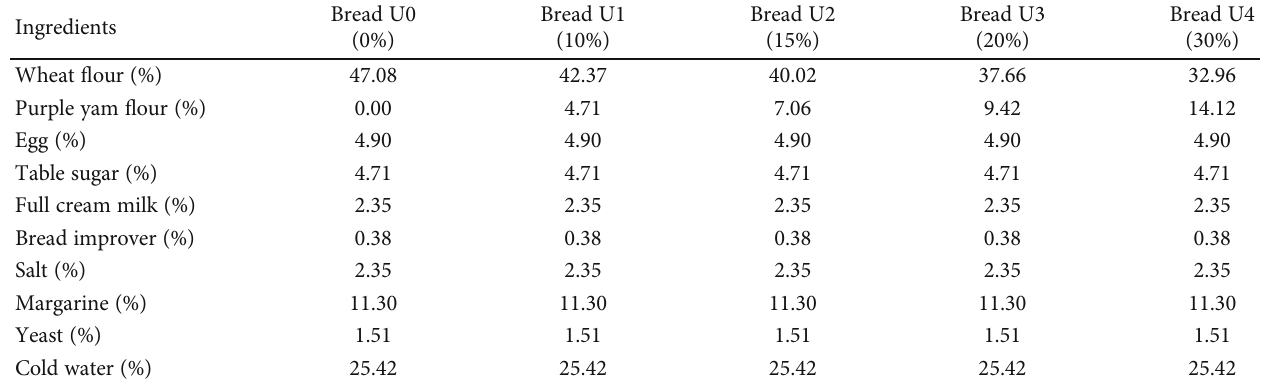
Table 1: Ingredient formulation for plain bread with di ff erent yam fl our addition. Ingredients